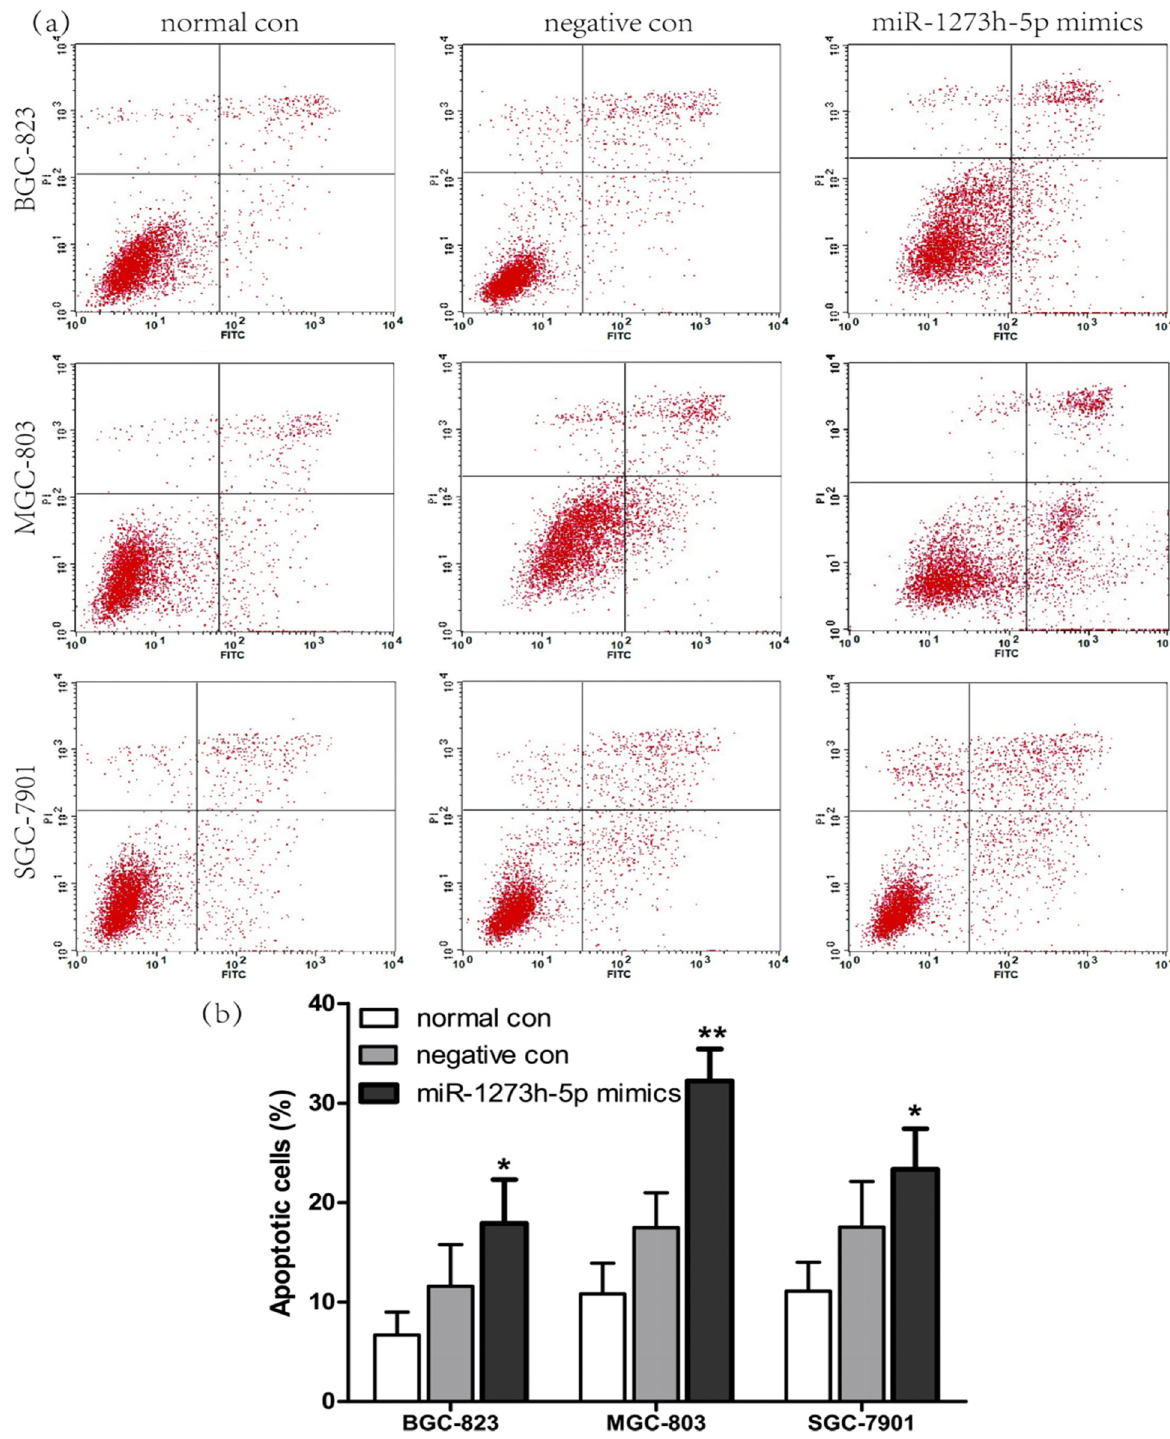
Figure 3: E ff ect of miR - 1273h - 5p on GC cell apoptosis. ( a ) E ff ect of miR - 1273h - 5p on apoptosis of BGC - 823, MGC - 803, and SGC - 7901 cells at 24 h after transfection evaluated using FCM. ( b ) Apoptotic rates of BGC - 823, MGC - 803, and SGC - 7901 cells at 24 h after transfection of miR - 1273h - 5p mimic. Compared to the negative control, the apoptosis ratio of miR - 1273h - 5p mimics was signi fi cantly increased. All data were expressed as M ± SD from three independent experiments compared with the negative control group, * P < 0.05, ** P <